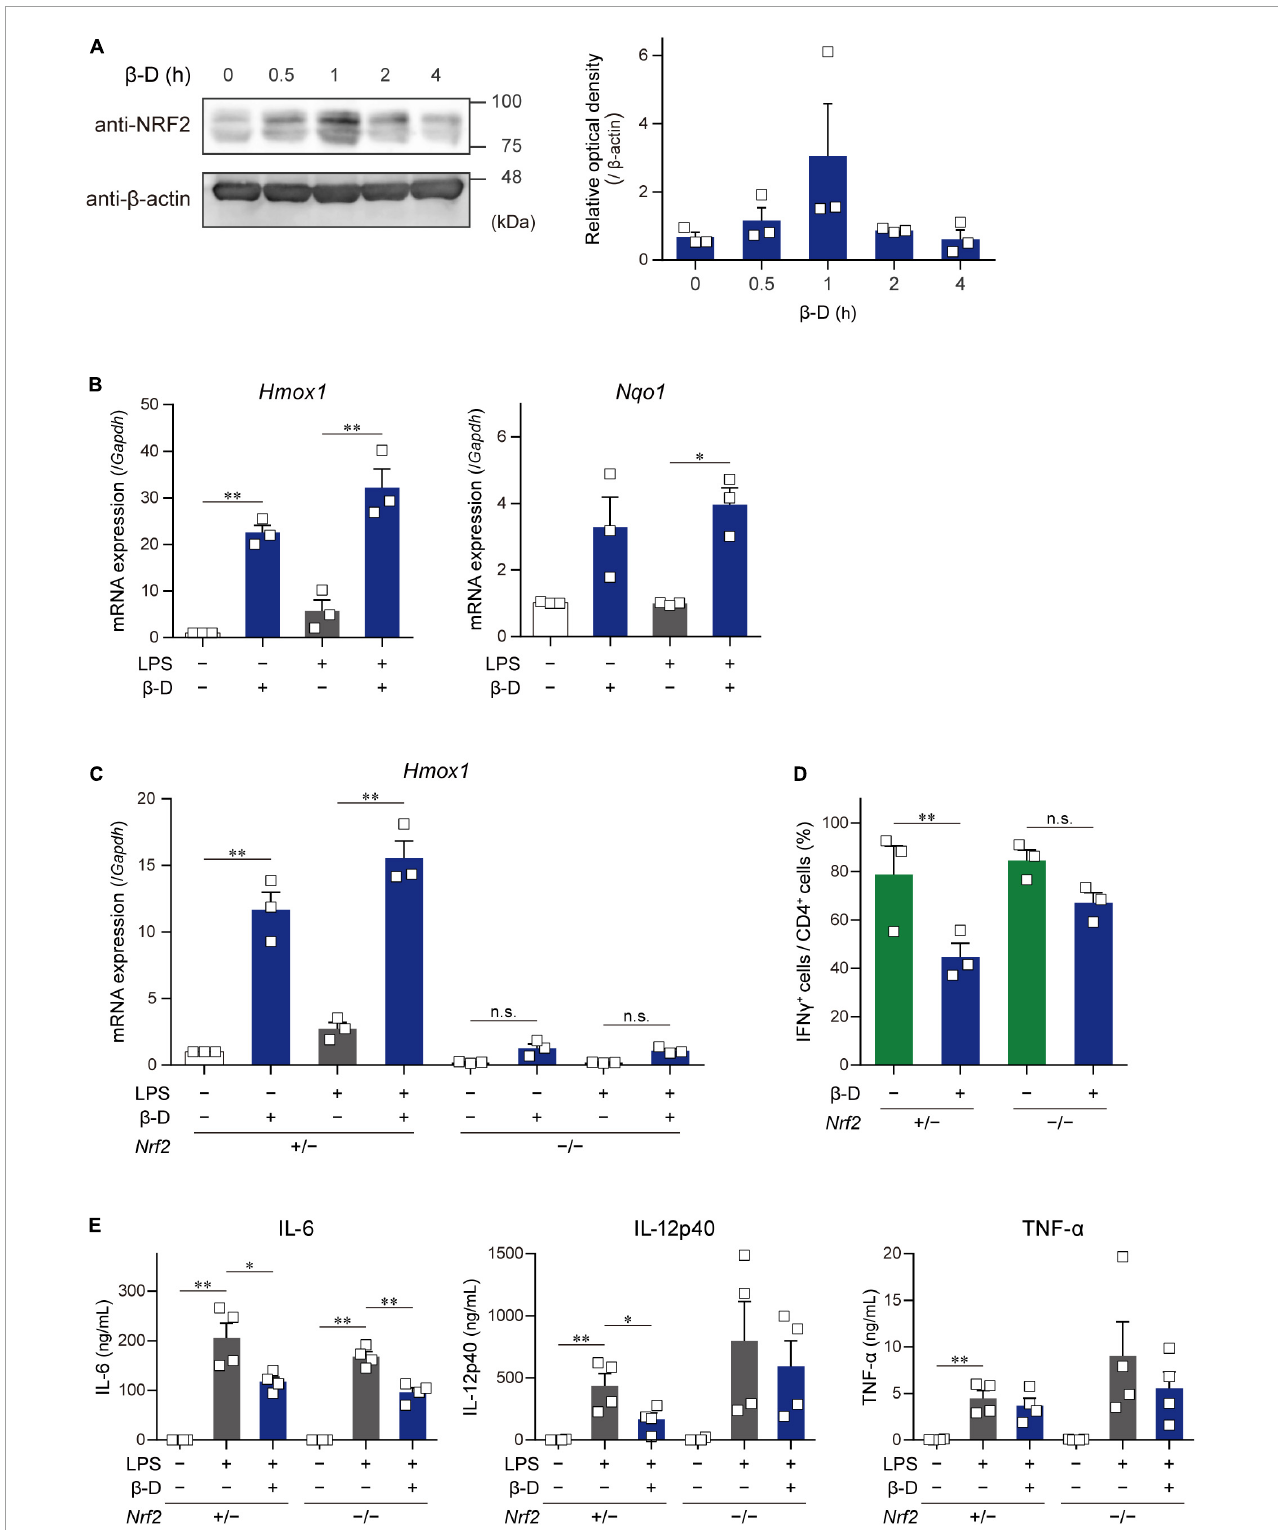
FIGURE4 β -Damascone activated the NRF2 signaling in DCs, and a NRF2 deficiency attenuated its suppressive effects. (A) Left: A Western blot profile showing NRF2 protein levels in BMDCs following a treatment with β -damascone. BMDCs were incubated in the presence of 50 µ M β -damascone for the indicated times. The lysate aliquots of whole cells containing 15 µ g of protein were loaded to each lane. Right: Data of three independent experiments were quantified by calculating the band intensity, and shown as the ratio of (NRF2) / ( β -actin) versus those seen in control DCs (0 h). (B) Hmox1 and Nqo1 mRNA levels in BMDCs. BMDCs cultured in the presence or absence of 50 µ M β -damascone for 24 h were incubated with or without 100 µ g/ml LPS for an additional 3 h. (C) Hmox1 mRNA levels in BMDCs generated from NRF2-deficient mice ( Nrf2 − / − ) and control mice ( Nrf2 + / − ). (D) Th1 development induced by a coculture with Nrf2 − / − BMDCs or control BMDCs. (E) LPS-induced cytokine production by Nrf2 − / − BMDCs and control BMDCs. Data represent the mean ± SEM of more than three independent experiments performed in triplicate. The Tukey-Kramer test was used. ∗ p < 0.05, ∗∗ p < 0.01, n.s.: not